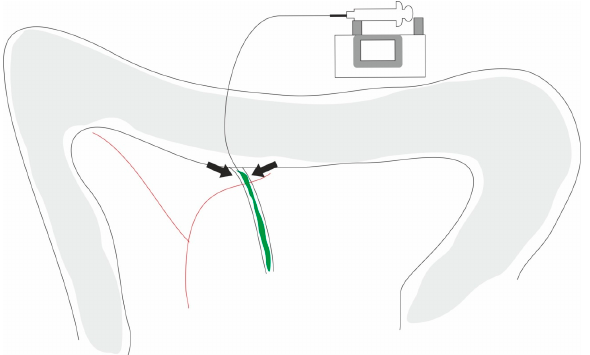
Figure 3. Biliopancreatic duct injection acute pancreatitis model. Image: picture showing the retrograde ductal infusion technique. According to aseptic techniques, the duodenum is exposed by a laparotomy, and the common biliopancreatic duct is identified and cannulated; after the retrograde infusion, the duct is ligated (arrows).